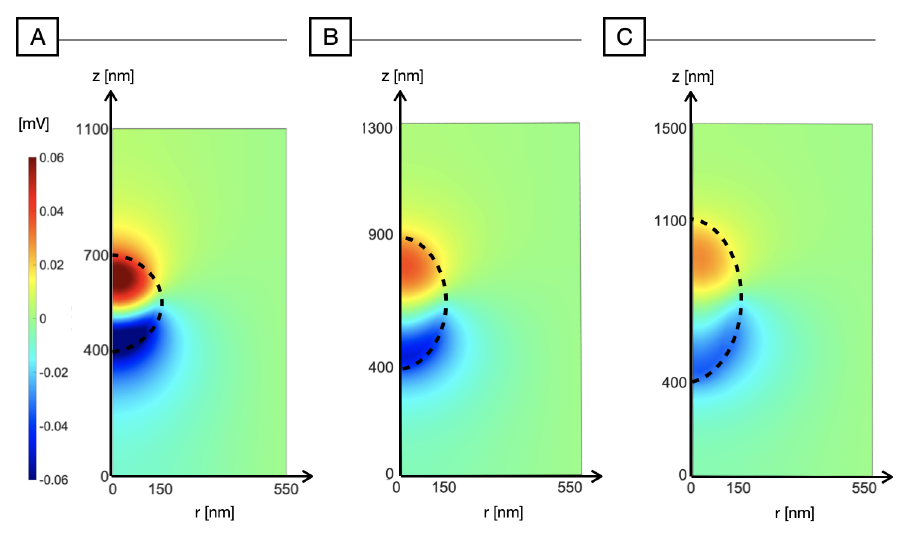
Figure 5. Electric potential distribution (mV) across the nanoparticle and the surrounding medium for increasing ellipticity of the NP. To enhance ellipticity, we increase the radius r 2 parallel to the z − axis and to the light-impinging direction, while the radius r 1 perpendicular to light is kept fixed at 150